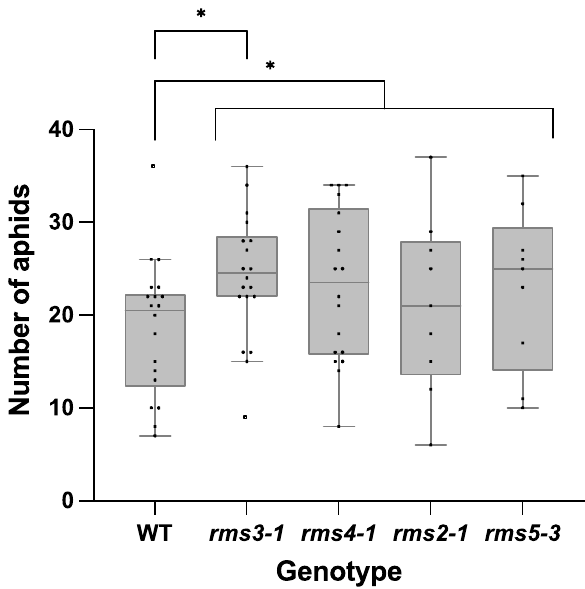
Figure 5. Aphid fecundity on wild type peas and mutants defective either in strigolactone (SL) synthesis ( rms1 - 2 and rms5-3 ) or signaling ( rms3 - 1 and rms4-1 ) grown under ambient CO 2 conditions. A single pea aphid nymph was placed on each 5-day-old plant. Plants were then grown in air for 15 days before aphid numbers were counted. Significant differences between genotypes are indicated as: * p < 0.05. Strigolactone mutants as a group were also significantly different from the wildtype. Wildtype (WT) and rms3-1 , n = 19; rms4-1, n = 18; rms2-1 and rms5-3 , n = 9.